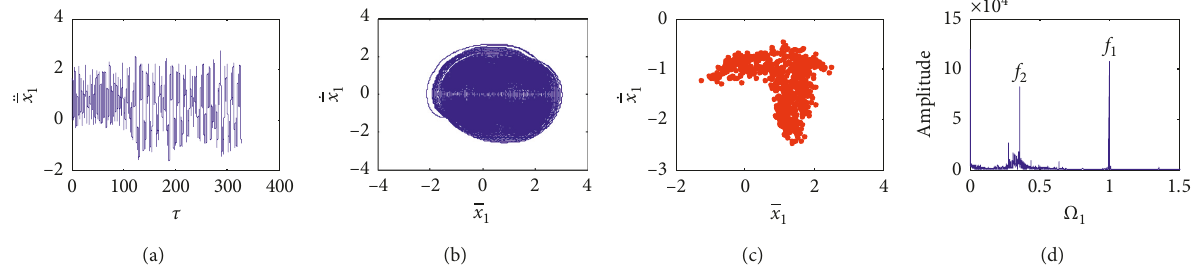
Figure 8: Vibration characteristics when Ω � 1.5: (a) time domain, (b) phase diagram, (c) Poincar´e section, and (d) frequency domain. 1